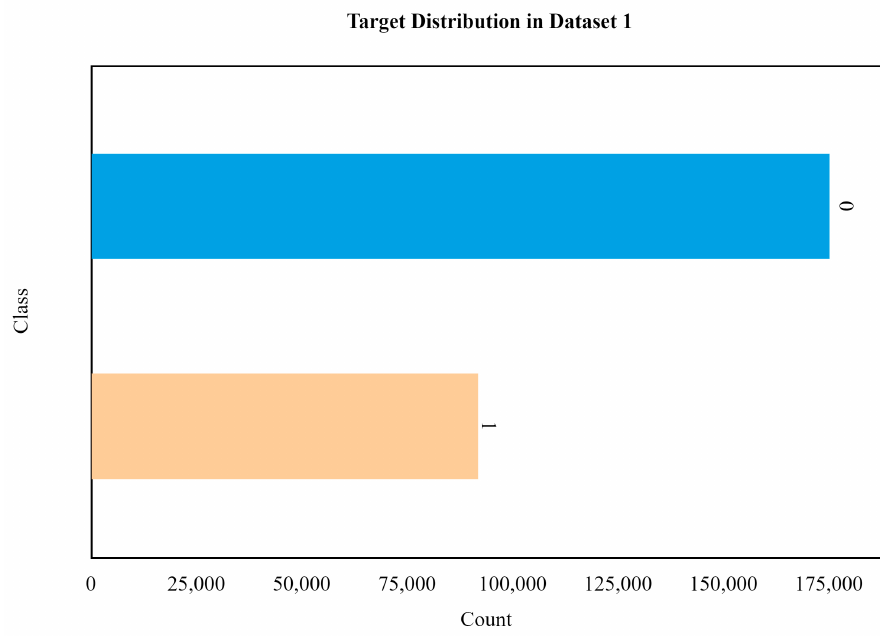
Figure 4. Target Distribution in UNSW-NB15 Dataset.